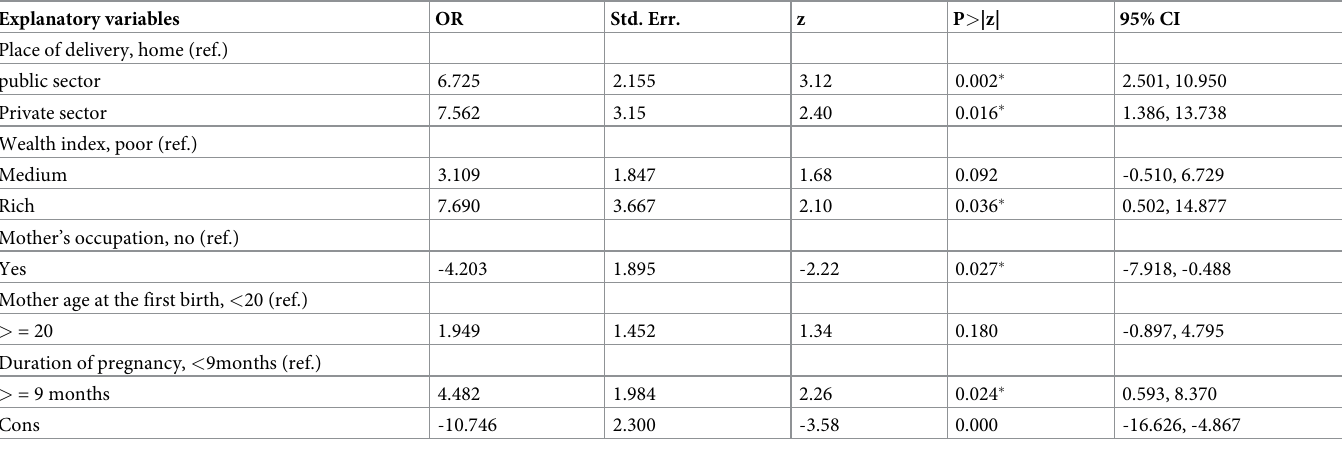
Table 6. ZIP regression model parameter estimation for zero groups. Explanatory